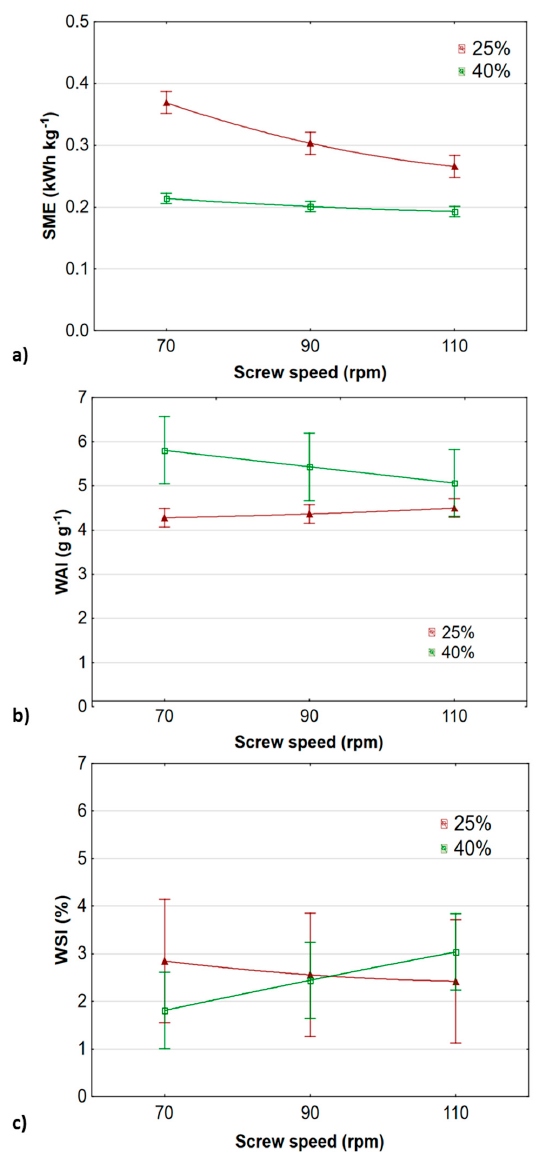
Figure 2. Selected properties of corn straw extruded under various screw speeds and moisture content: ( a ) energy consumption, ( b ) water absorption index, ( c ) water solubility index.